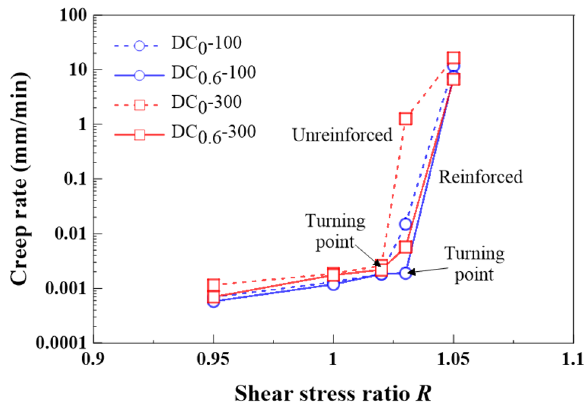
Figure 13. Creep rate-shear stress ratio relationships for the unreinforced and reinforced specimens under σ n = 100 kPa and σ n = 300 kPa.